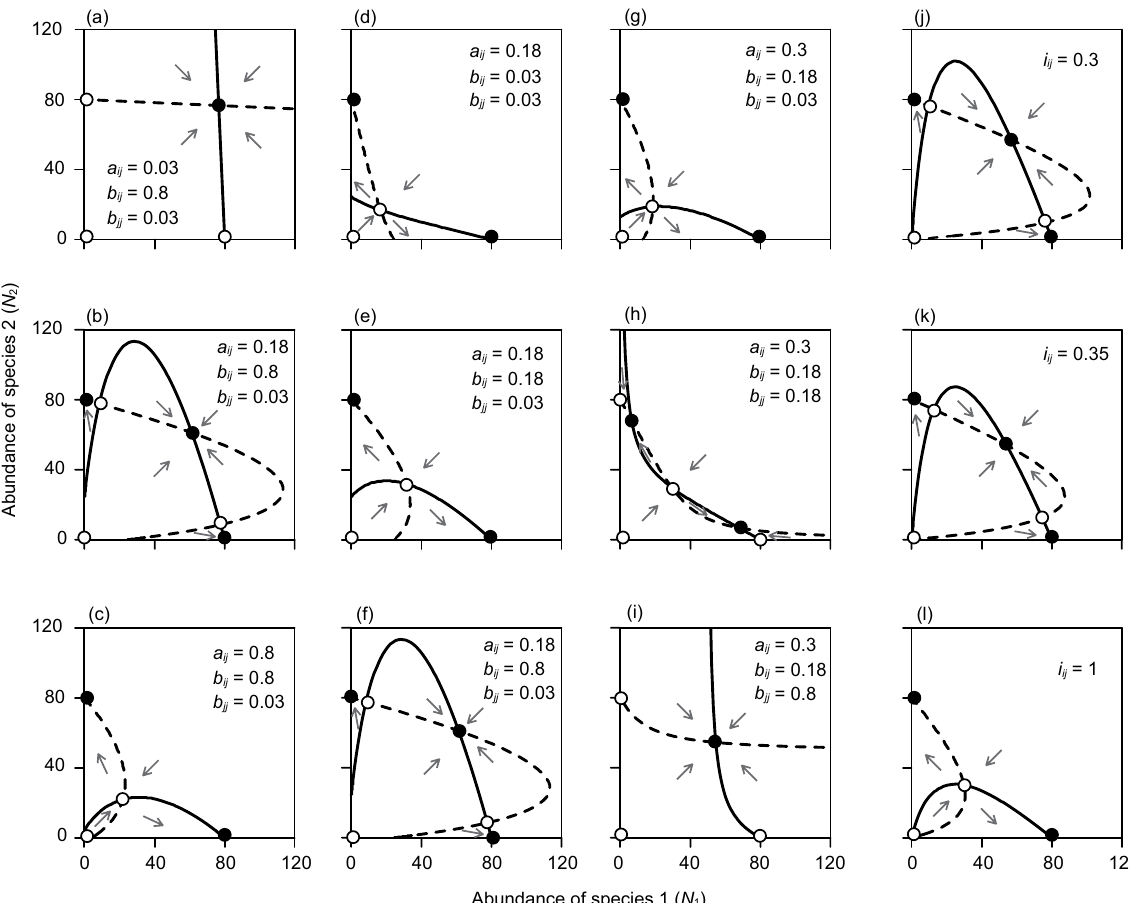
Figure 1. Parameter dependence of the zero-growth isocline for the generalized model ( a – i ) and the conventional model ( j – l ), with identical parameter values for the two species. Solid and broken lines are isoclines for species 1 and 2, respectively. Filled and open circles are stable and unstable equilibria, respectively. In ( a – c , d – f and g – i ) a ij , b ij and b jj in equation (7) are varied, respectively. In ( j – l ) i ij in equation (8) is varied. Arrows indicate increase/decrease of N 1 and N 2 in each region of the phase plane. Other parameters used: ( B i 0 , s i , s j , S , D i ,